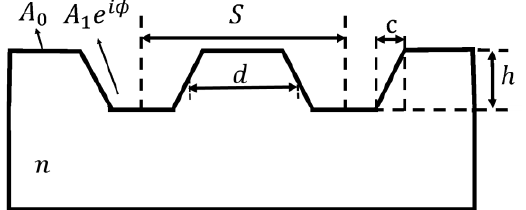
Figure 1. Cross-section of the binary linear grating model. Herein, S is the period, h is the etching depth, c is the project length of sidewall in the horizontal direction and d is the width of the grating ridge. The duty cycle D is defined as D = d / S and the sidewall slope ratio L is given by L = c/ S . In addition, A 0 and A 1 correspond to the amplitude of the output wavefront from the unetched and etched areas of the grating, respectively. For a phase grating made of a material with refractive index n , the phase step ϕ is defined as 2π( n − 1) h / λ , where λ is the wavelength of incident light set to 632.8 nm.